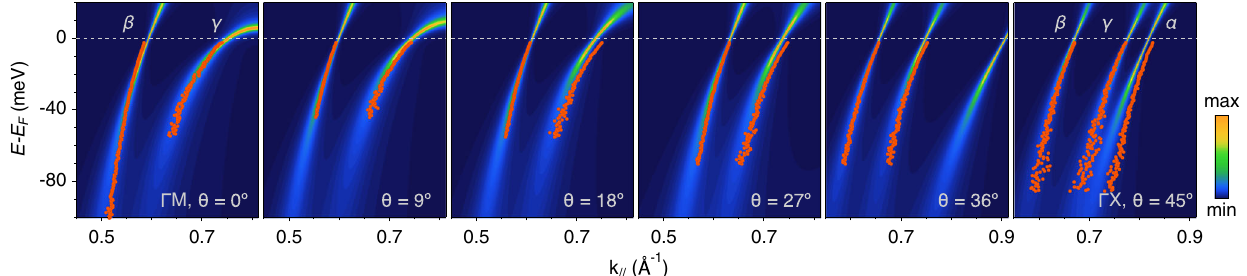
FIG. 5. Comparison of experimental quasiparticle dispersions (markers) with DMFT spectral functions (color plots) calculated for different Fermi surface angles θ .